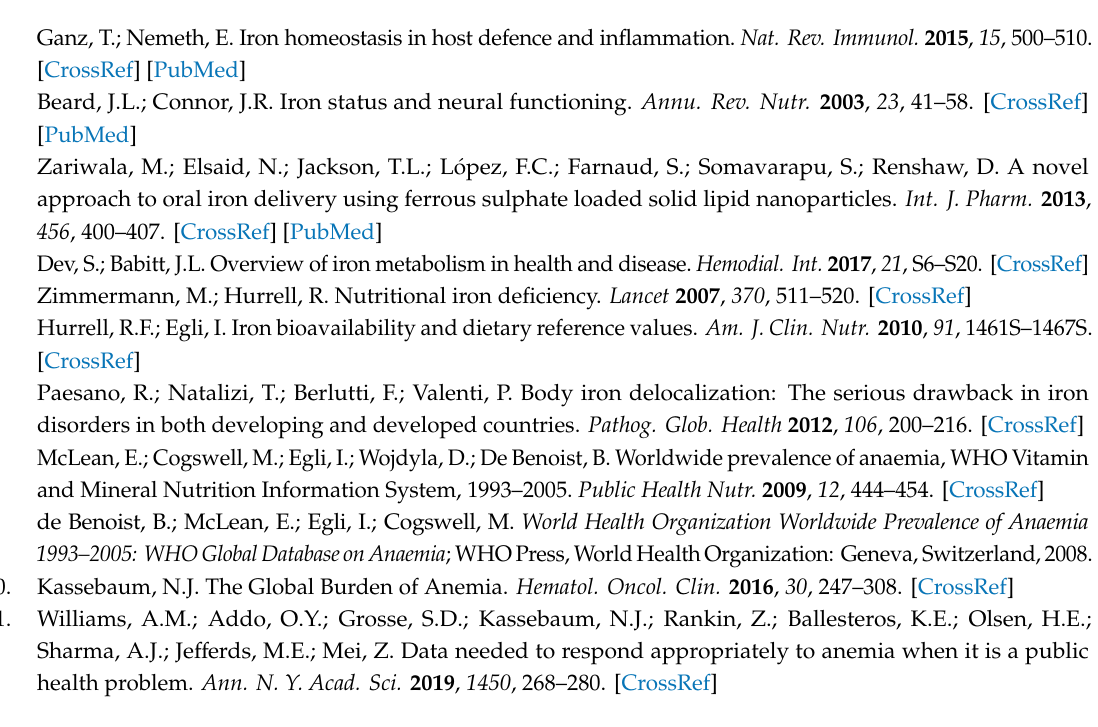
treatment groups: FS0 + Plac (full placebo, placebos for both iron and curcumin), FS18 + Plac (18 mg elemental iron and placebo for curcumin), FS18 + Curc (18 mg elemental iron and 500 mg curcumin), FS65 + Plac (65 mg elemental iron and placebo for curcumin) and FS65 + Curc (65 mg elemental iron and 500 mg curcumin). Table S1: Mean BDNF (ng / mL) values per treatment group / timepoint (mean ±